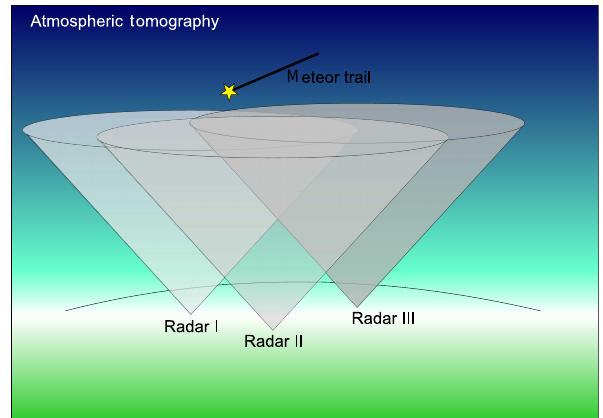
Figure 1. Schematic of a multi-static meteor radar network. The grey shaded areas stand for the typical field of views for each sys- tems. Within the network all system should at least overlap to one of the other network